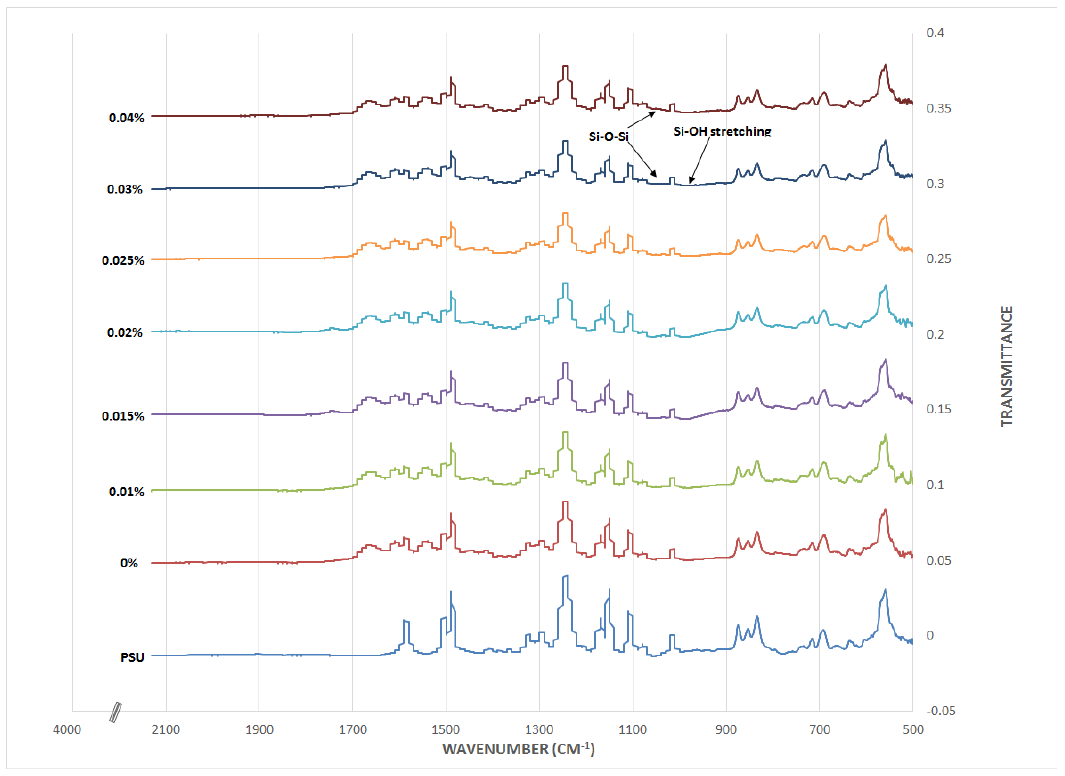
Figure 5. Cont . Figure 5.